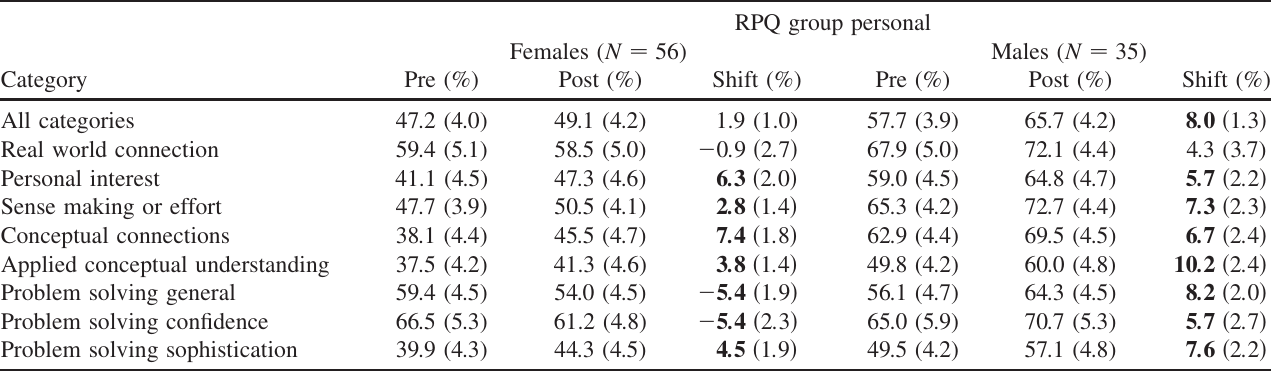
EFFECTS OF TWO DIFFERENT TYPES OF . . TABLE VI. Relationships between all categories and gender for RPQ group in pre-CLASS and post-CLASS test [standard error in parentheses; large shifts ( p < 0 : 05 ) in bold font].